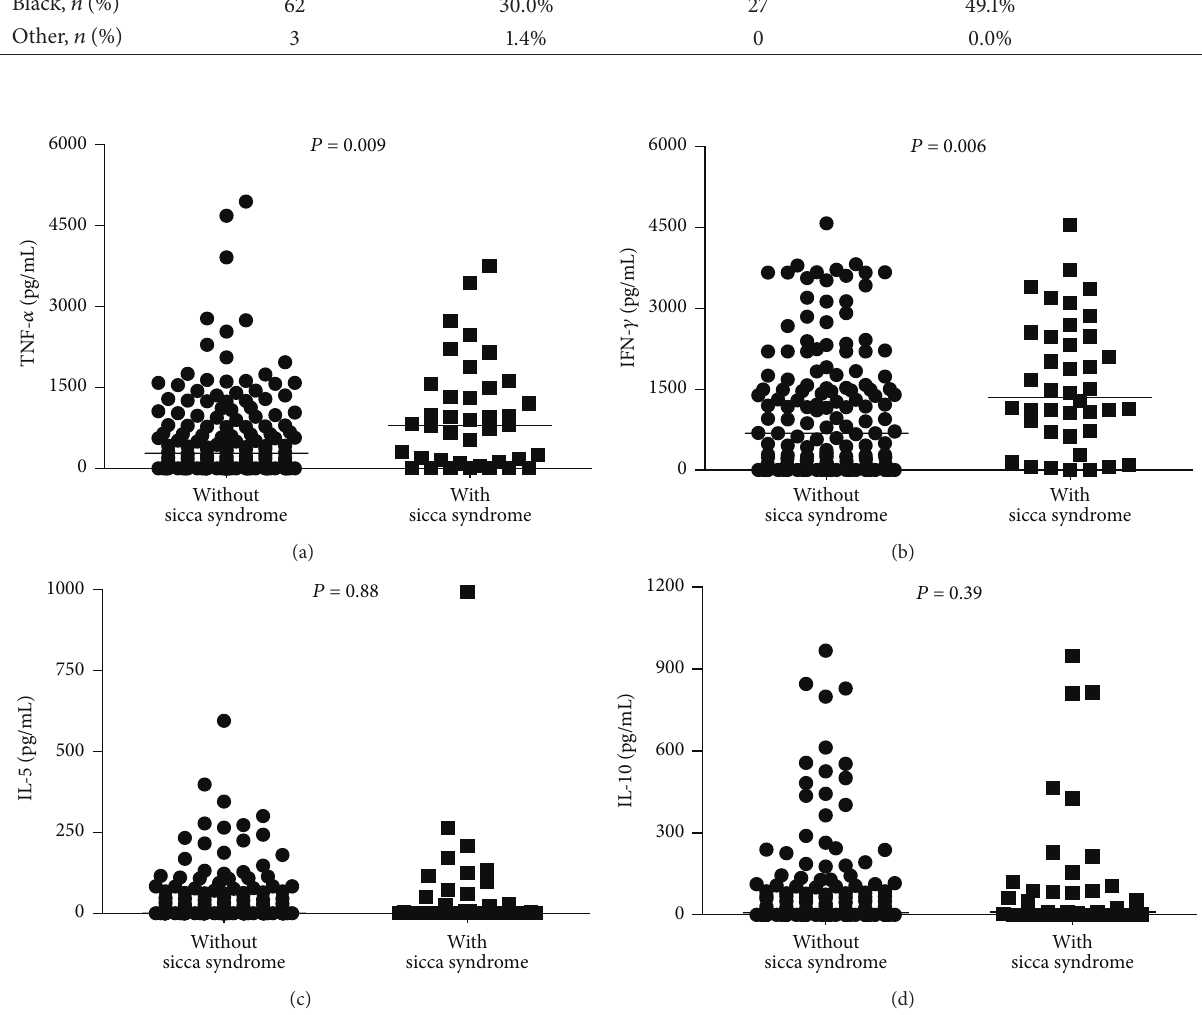
Figure 1: Levels of TNF- 𝛼 (a), IFN- 𝛾 (b), IL-5 (c), and IL-10 (d) produced by PBMC from HTLV-1 infected individuals with and without sicca syndrome. Cytokines data represent the values in unstimulated cultures. The levels of cytokines were measured by